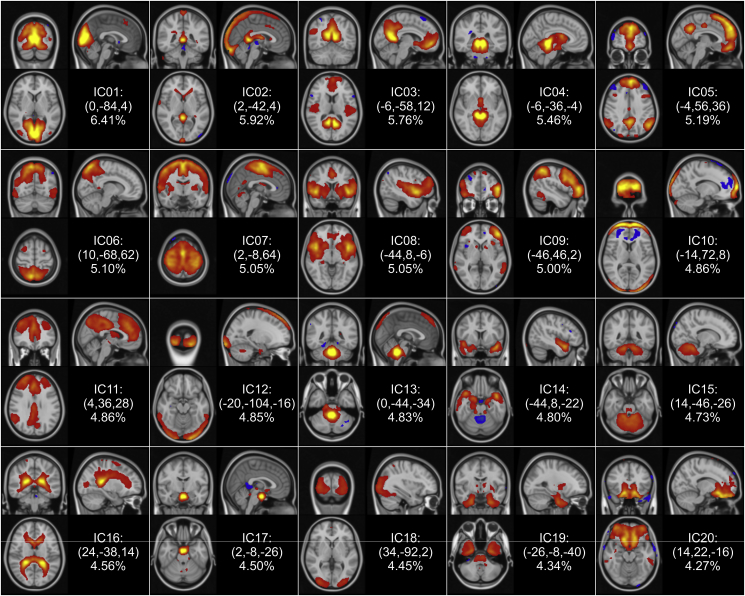
Group-level components of the NYU-TRT data. The 20 group-level independent components (ICs) obtained with temporal concatenation group ICA are shown in coronal, sagittal and axial planes going through the peak coordinates (shown in parentheses in MNI standard coordinates) according to radiological convention. The z-statistic maps are ordered according to the percentage of explained variance, and thresholded based on MELODIC's spatial mixture model at Z > 3.